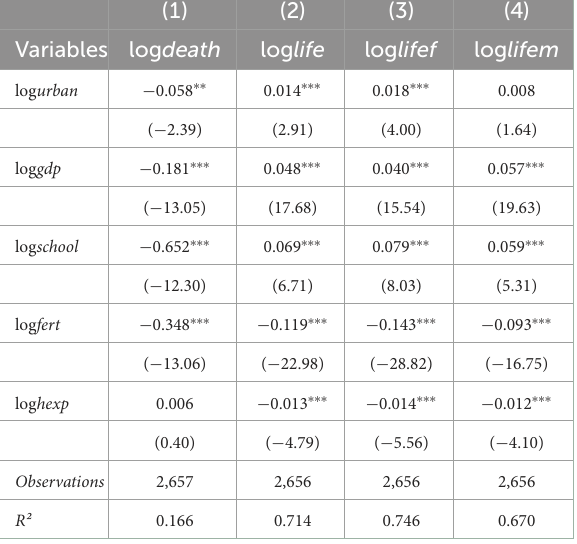
Table 5. To make the results more precise, we reproduce the above regression results using two-way fixed effect estimation in column (1) of Table 5. Column (2) of Table 5 reports the bound estimation. The result shows that the interval formed by β does not contain 0. It means that our two-way fixed effect estimations are robust to potential omitted variable bias.